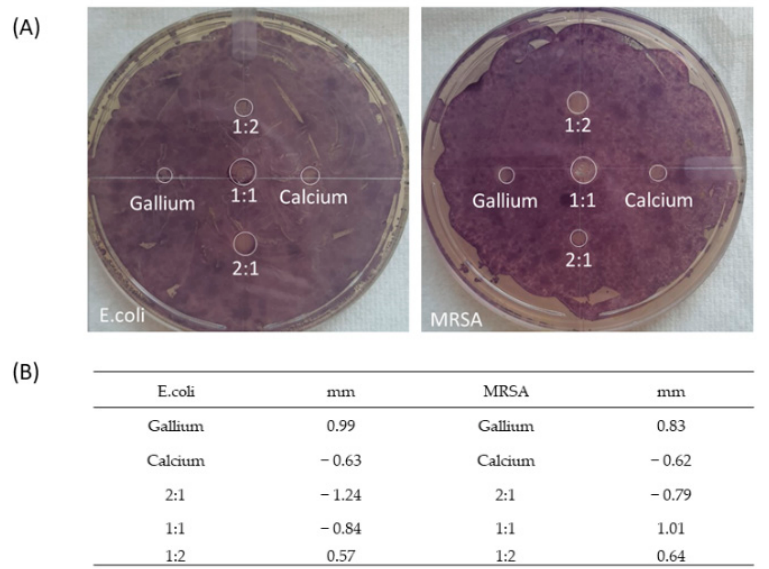
Figure 8. Zone of inhibition combined with MTT to highlight bacterial activity around calcium alginate, gallium alginate, calcium gallium alginate 1:1, calcium gallium alginate 1:2 and calcium gallium alginate 2:1. ( A ) image, ( B ) zone size data.